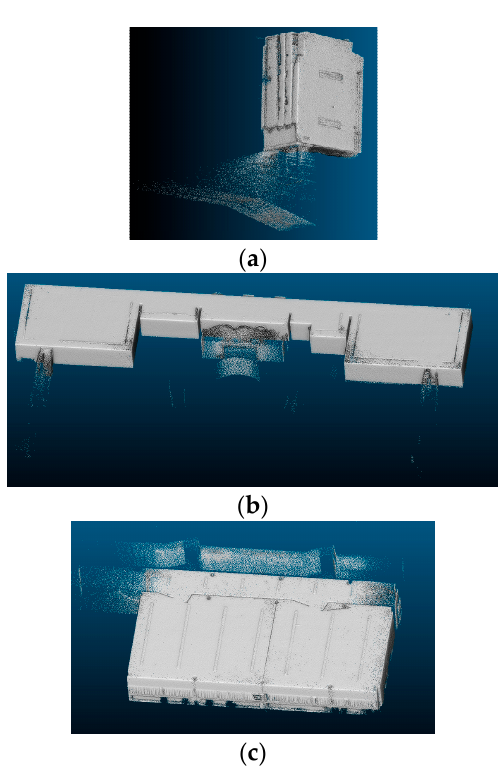
Figure 7. Cases of study: ( a ) Scenario 1; ( b ) Scenario 2; ( c ) Scenario 3.